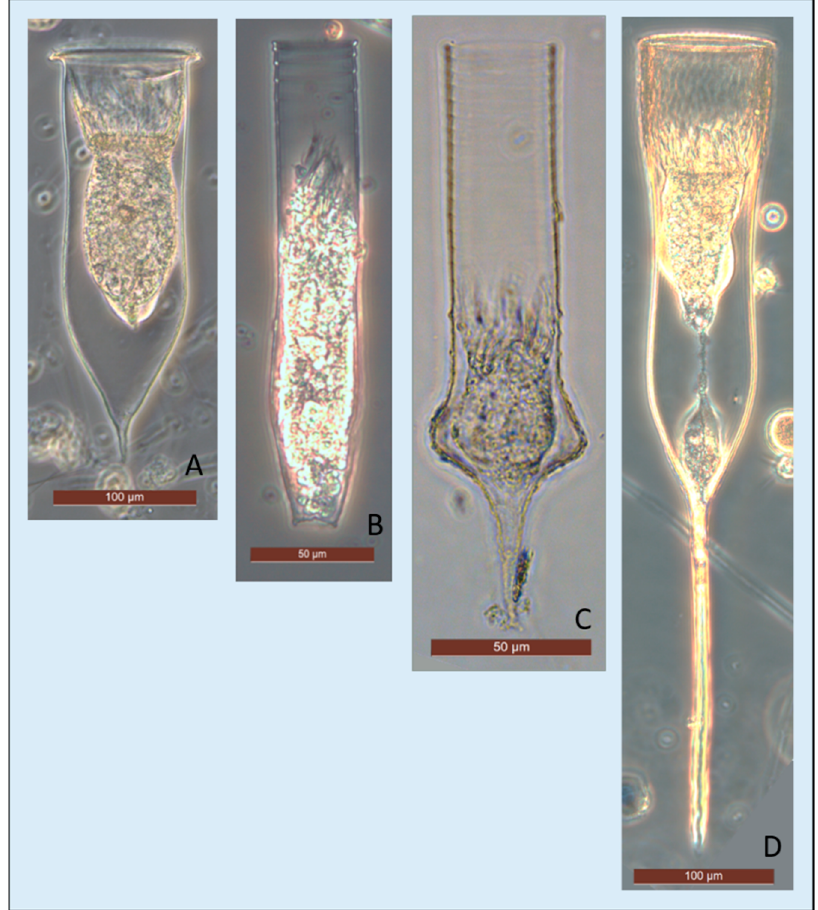
Figure 5. The most representative species detected in the study area. ( A ) Cymatocylis drygalskii , ( B ) Laackmanniella naviculaefera , ( C ) Codenollepsis gaussi , ( D ) Cymatocylis vanhöffeni. Table 2. List of tintinnid species recorded during the considered period (1988–2017) along the whole water column. (*) species presence.